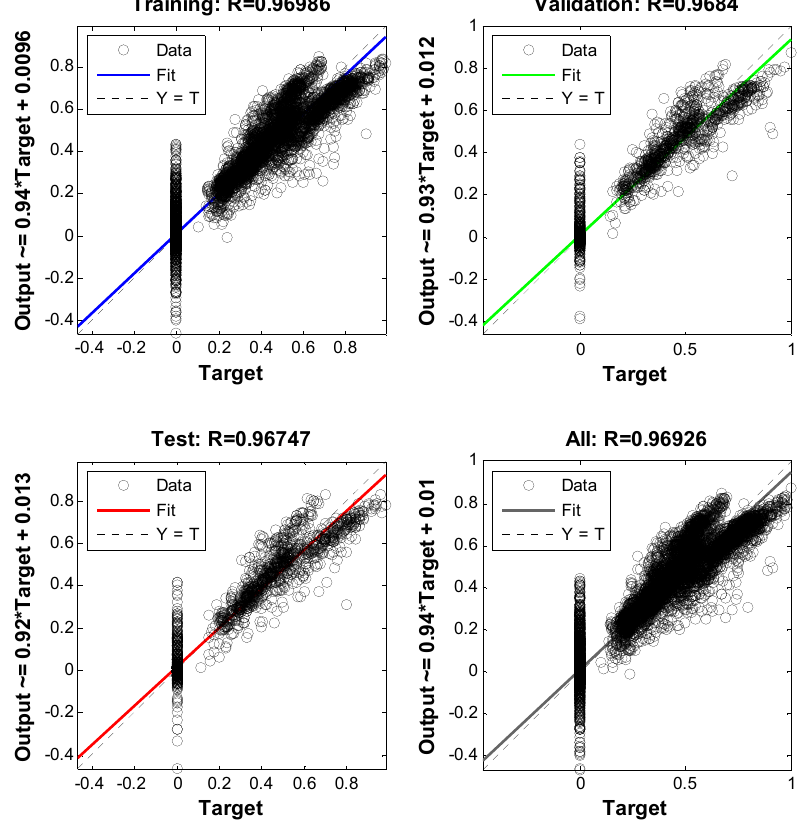
Figure 3. Data output and model performance criteria optimised via neural networks.